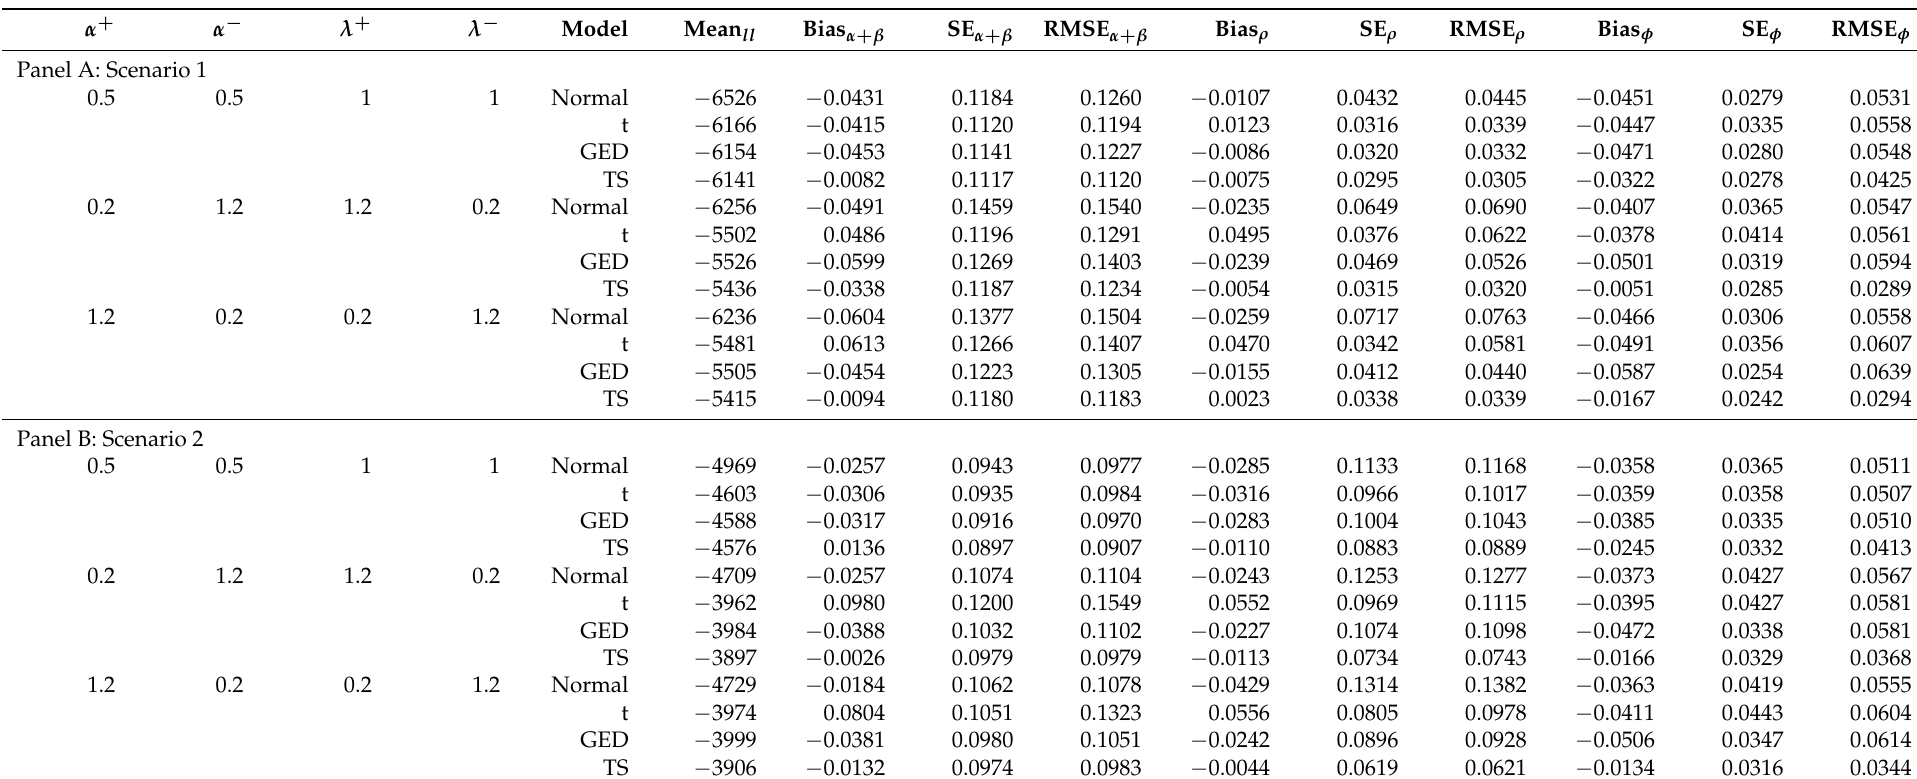
Table 3. Simulation results: tempered stable